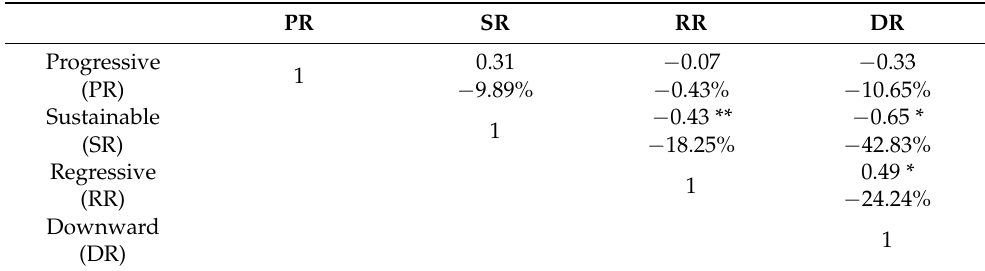
Table 3. Spearman’s rank correlation coefficients ρ S and determination coefficients ( R 2 in %) matrix between descriptive levels of organisational resilience